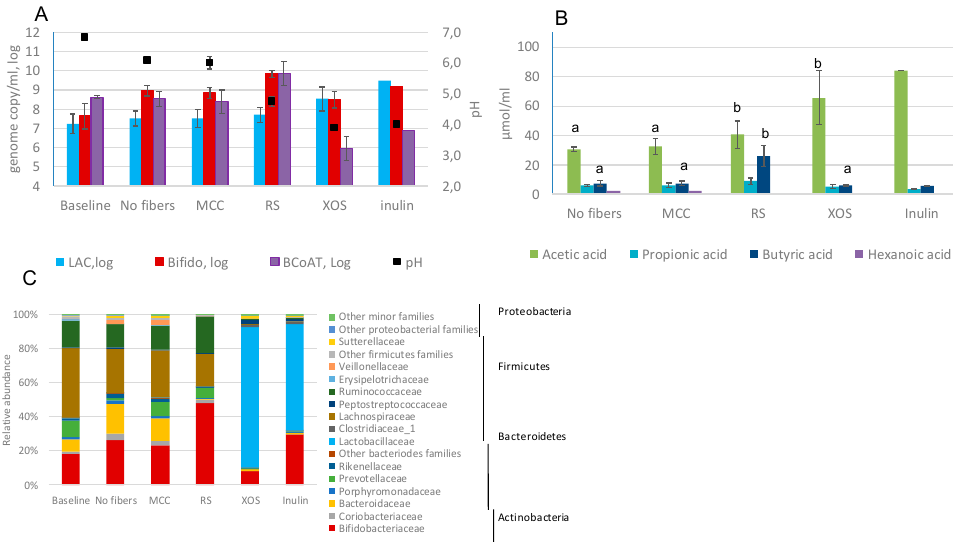
Figure 1. The bacterial population changes and SCFA accumulation after 48 h fecal fermentation of commercial dietary fiber preparations. ( A ) The number of main microbial groups as defined by qPCR; ( B ) the concentration of SCFAs at the end on the fermentation; ( C ) bacterial community profile at family level. LAC— Lactobacillus group, Bifido— Bifidobacterium spp., BCoAT—butyryl-CoA:acetate CoA-transferase gene; MCC—microcrystalline cellulose, RS—resistant starch, XOS—xylo-oligosaccharide. Values with different letters showed significant differences among the groups ( p < 0.05). The samples with inulin were not included in analysis of variance (ANOVA) since only duplicates were available for the analysis.